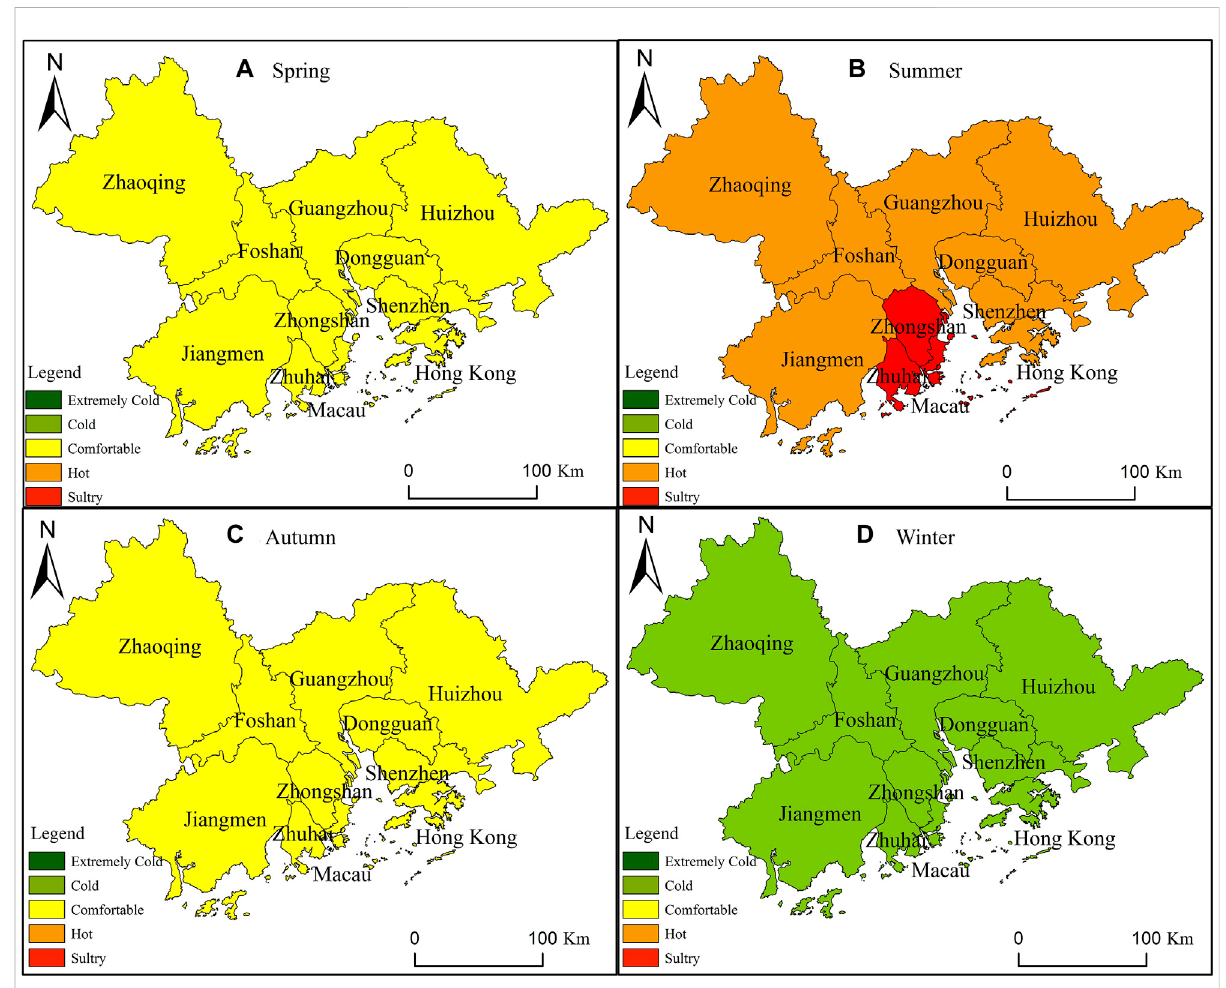
FIGURE 8 Seasonal change of climate comfort of human settlements in the Guangdong – Hong Kong – Macau Greater Bay Area in